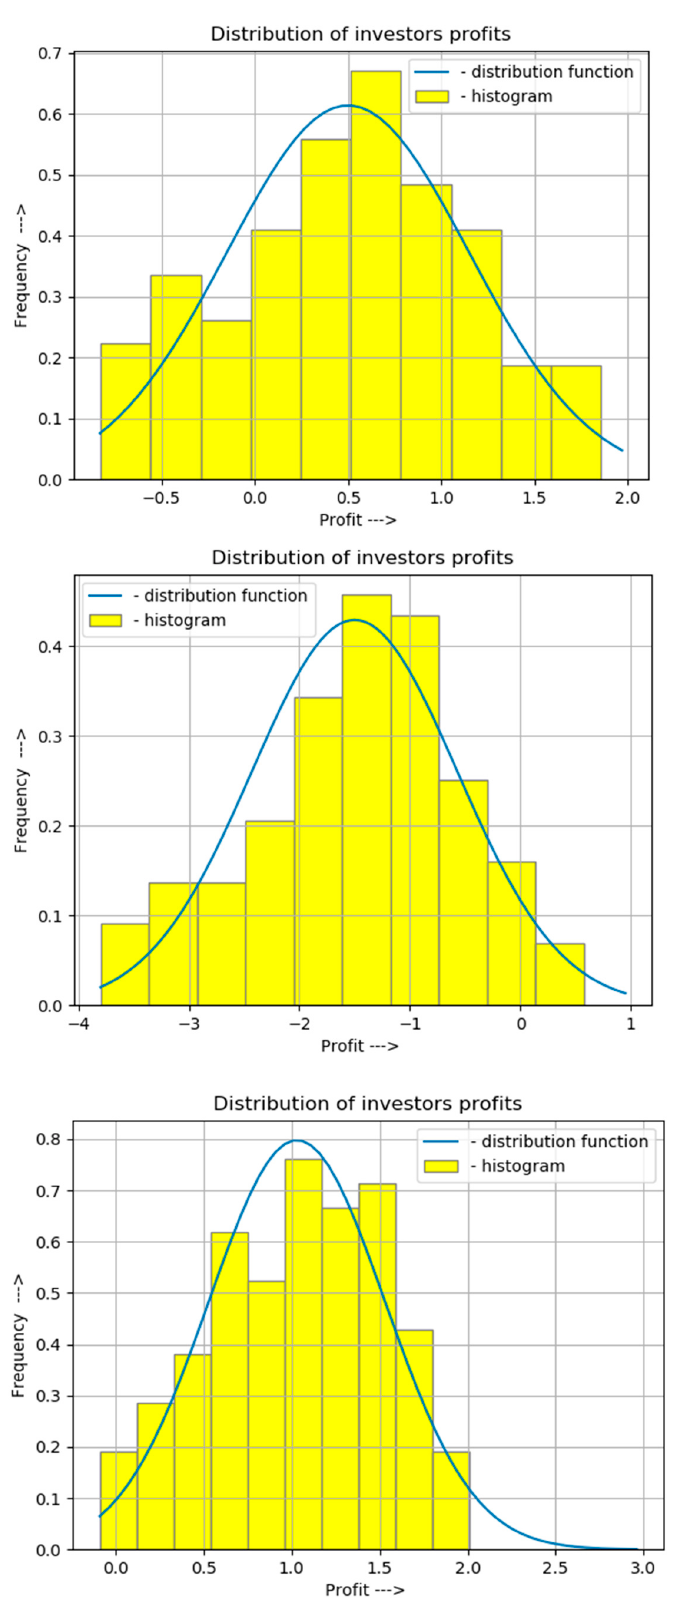
Figure 4. Histogram and theoretical curve of investors’ profit distribution in projects dedicated to the production of biohydrogen from agricultural raw materials.